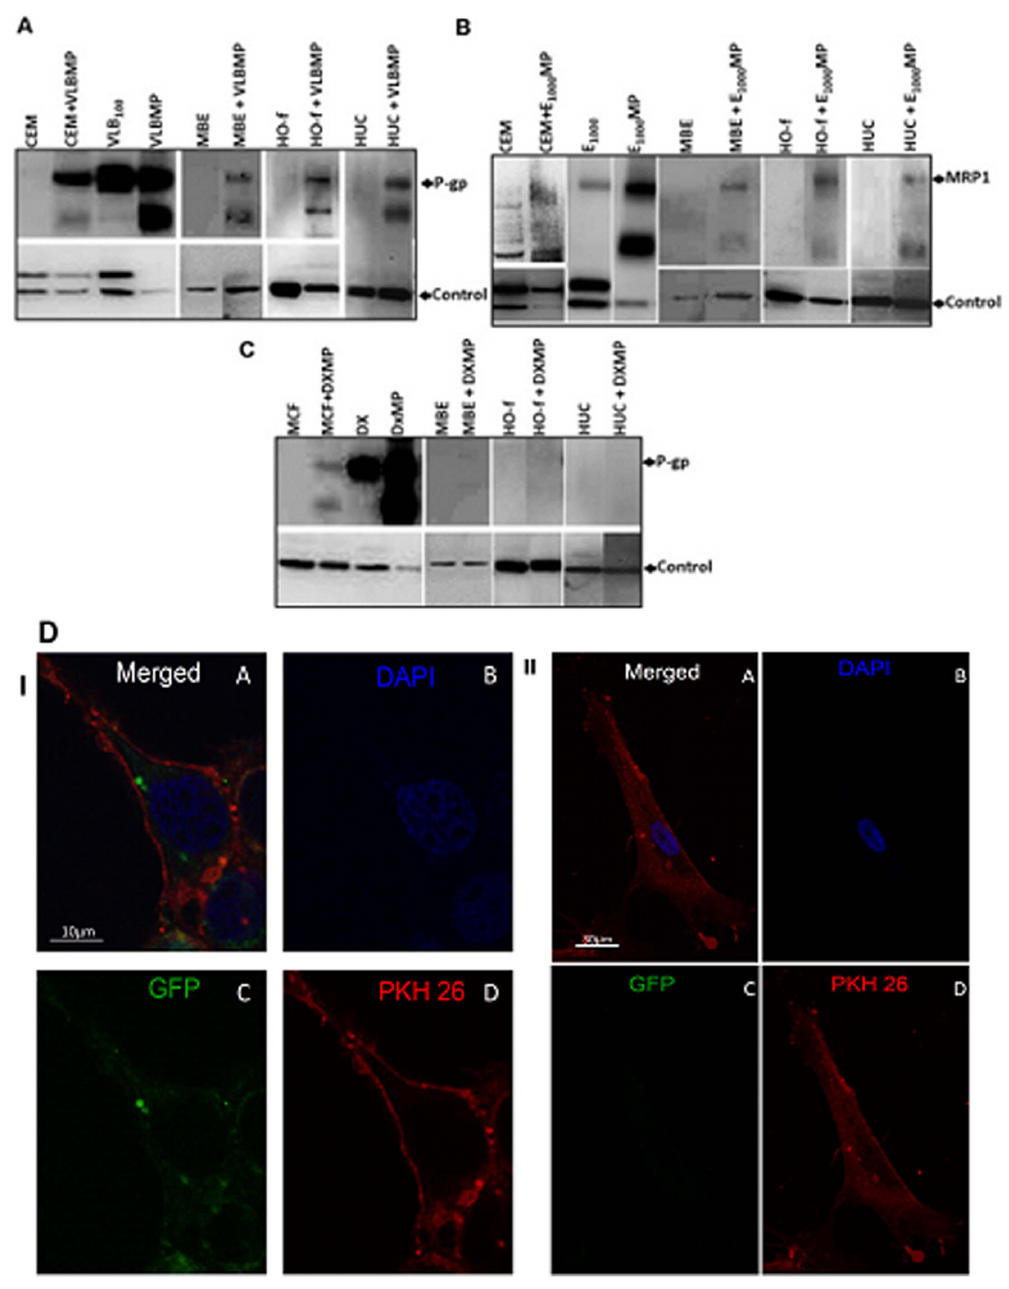
Figure 1. Selective transfer of P-gp to MCF-7 breast cancer cells by DXMPs by Western Blot analysis. 20 m g total cell lysates of non- malignant cells (breast epithelial cells (MBE), osteoblasts (HO-f) and urothelial (HUC) cells) and their co-cultures; and drug sensitive cancer cells (leukaemia, CEM and breast cancer, MCF-7) and their co-cultures with leukaemic cell-derived ( A ) VLBMP and ( B ) E 1000 MP overexpressing P-gp and MRP1, respectively, and breast cancer-derived ( C ) DXMP overexpressing P-gp, were analyzed by Western blot analysis. ( A ) P-gp and ( B ) MRP1 were readily detected in the drug resistant leukaemic donor cells, their MPs and also in both the recipient malignant and non-malignant cells after MP transfer using the anti-P-gp mAb, F4 and anti-MRP1 mAb, QCRL-1, respectively. ( C ) P-gp was also detected in the drug resistant breast cancer donor cell, its MPs (DXMP), recipient malignant drug sensitive cells but not in the recipient non-malignant cells after MP transfer. a -tubulin or b -actin were used as internal loading controls. ( D ) Selective transfer of P-gp to MCF-7 breast cancer cells by malignant breast cancer-derived MPs by Confocal microscopy. Malignant breast cells MCF-7 ( I ) or non-malignant osteoblasts, HO-f ( II ) cells were stained with fluorescent membrane probes PKH26 and the nucleus was stained with DAPI after 4 hours co-culture with GFP-MPs. ( I ) P-gp was detected in the breast MCF-7 cells only and not in ( II ) the osteoblasts. Panel A shows all channels captured, Panel B shows the DAPI in the 405 nm channel, Panel C shows the transferred GFP (or lack of) in the 488 nm channel, and Panel D shows the PKH26 in the 561 nm channel. Images were acquired using the Nikon A1 confocal microscope. Scale bar as indicated. Both Western blot and confocal microscopy experiments were repeated at least 2–3 times with similar results. Data are representative of a typical experiment.